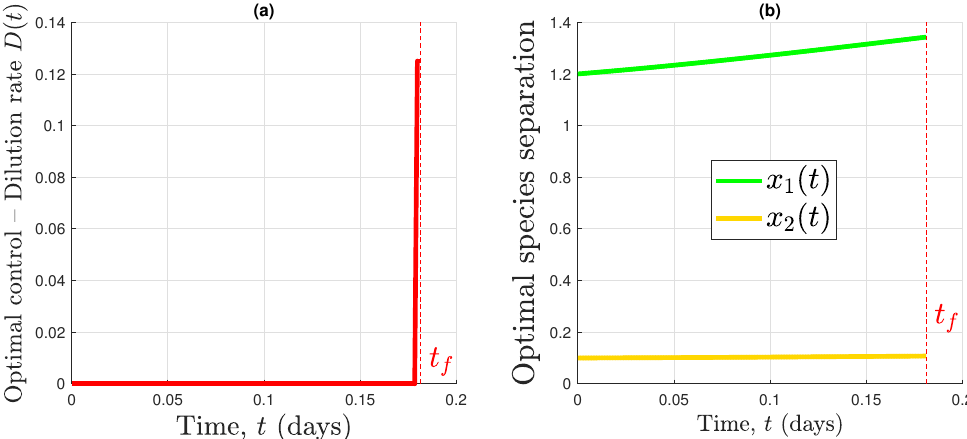
Figure 10. The optimal control given in ( a ) is bang(0) almost everywhere over [ 0, t f ) . It achieves species separation ( b ) and selects the species x 1 at t f = 1.1810 days, since x 1 ( t f ) = 1.3425 and x 2 ( t f ) / x 1 ( t f ) = ε = 0.08.